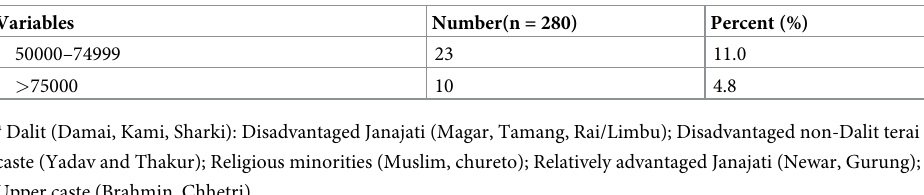
encing factors for initiating smoking and ever thought of quitting smoking. Participants of age